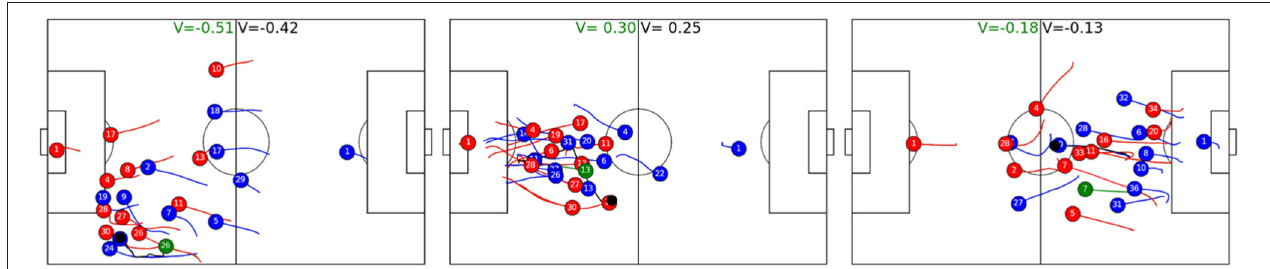
FIGURE 10 | Simulated and observed trajectories of midfielders and wingers with largest negative difference between observed and simulated V. The simulation starts 8 frames (0.32 s) after the opponent gaining possession of the ball and spans 4 s. Simulated players are depicted in green and V with simulated players are also labeled in green. In all cases, the simulated player tracked back slower after the opponent gained ball possession, yielding worse value function from the perspective of the defending team. In panel 1, observed red 26 added additional pressure on the ball carrier, whereas the simulated player is too far away. Panel 2 shows an instance where blue 13 is again closer to the ball-possessing player and reduces options for the players. In the last panel, red 7 runs back in full speed to put pressure on the ball carrier, whereas the simulated player runs back slower, effectively having no impact on the developing ball possession